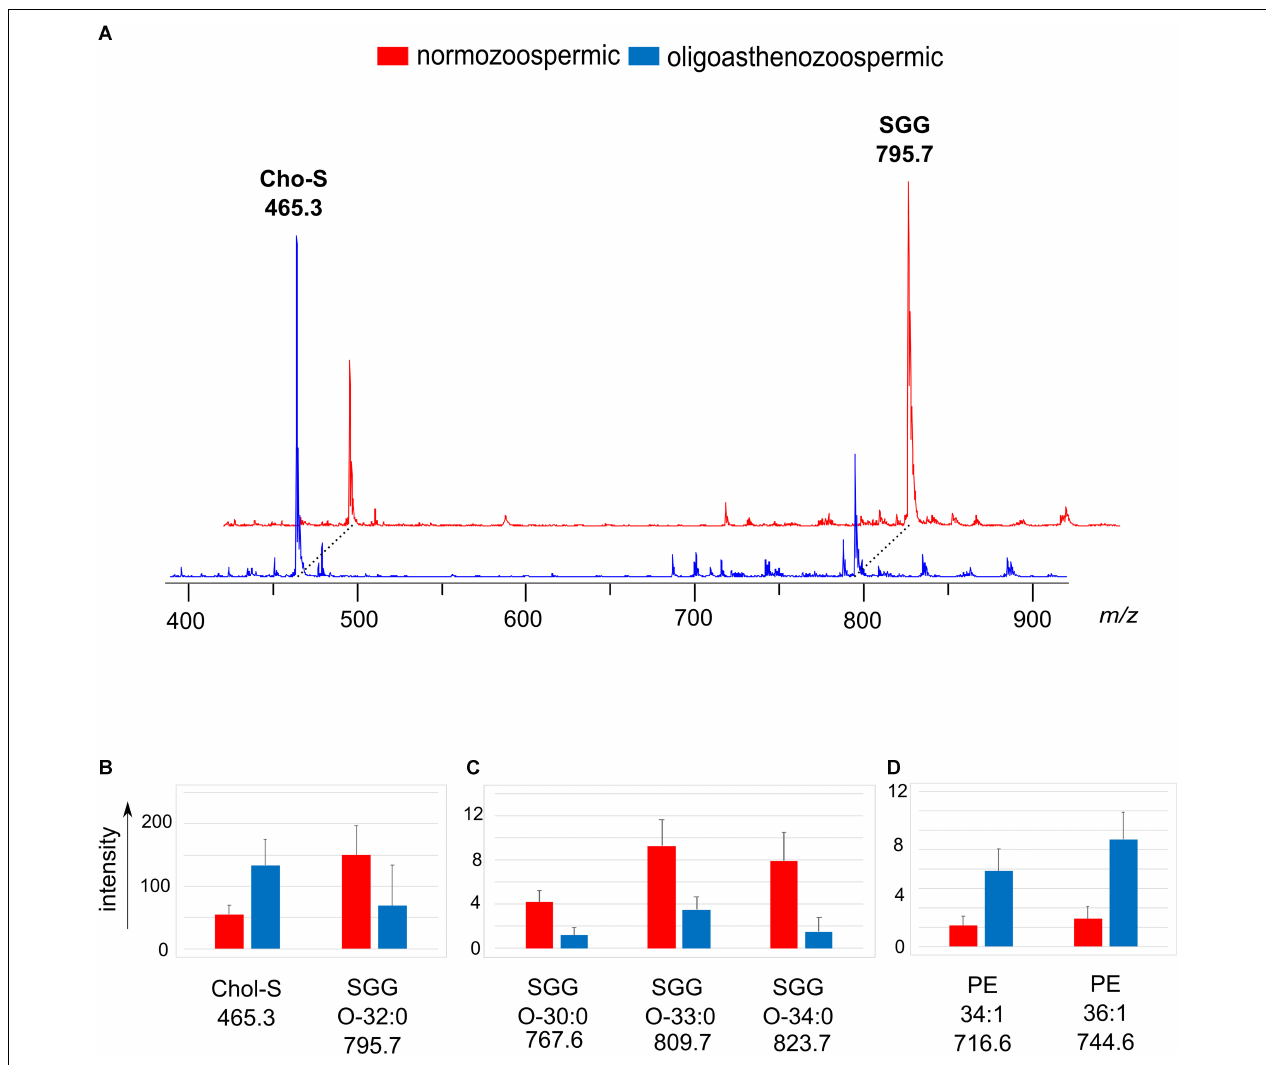
FIGURE 3 | Negative ion mode MALDI-TOF/MS analyses of the lipid extracts of semen of normozoospermic subjects and oligoasthenozoospermic patients. In panel (A) , two typical lipid profiles are shown. The histograms show the significant differences in intensity of lipid peaks at m/z 465.3 and 795.7 corresponding to Chol-S and SGG O-32:0 (B) , at m/z 767.6, 809.7 and 823.7 corresponding to main SGG species (C) , at m/z 716.6, 744.6 and 778.7 corresponding to PE species (D) . A p -value from Student’s t -test < 0.05 was set as the threshold to define significant differences between the peaks present in the two series of spectra. Data are reported as the average value ±